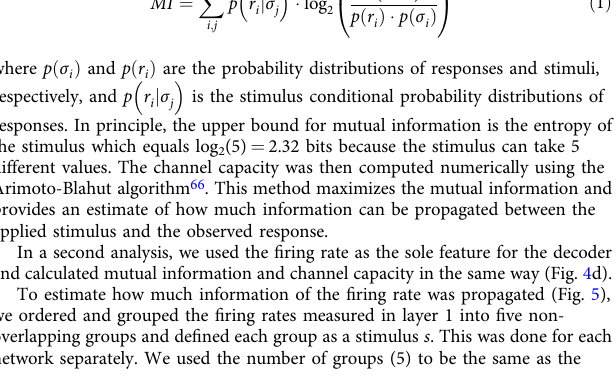
Table 1 yield amplitudes of about 2.3 mV and − 2.5mV for EPSPs and IPSPs, respectively. Synaptic conductances were scaled according to the scaling rule that we measured in the neuronal culture preparation: g ¼ g 0 =